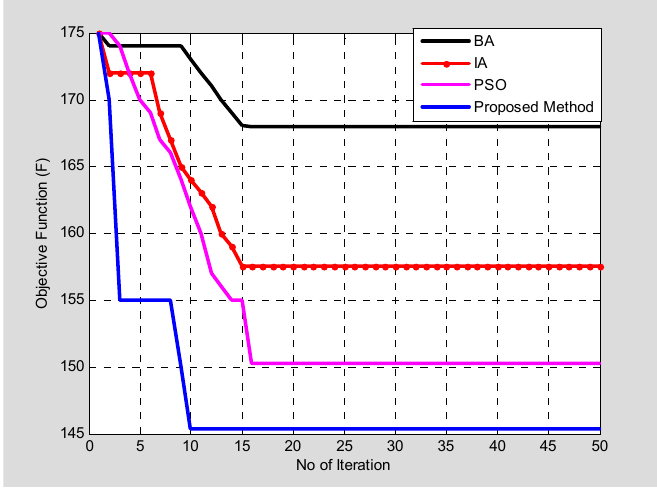
Figure 9. Comparison of convergence characteristics for standard 69-bus system.